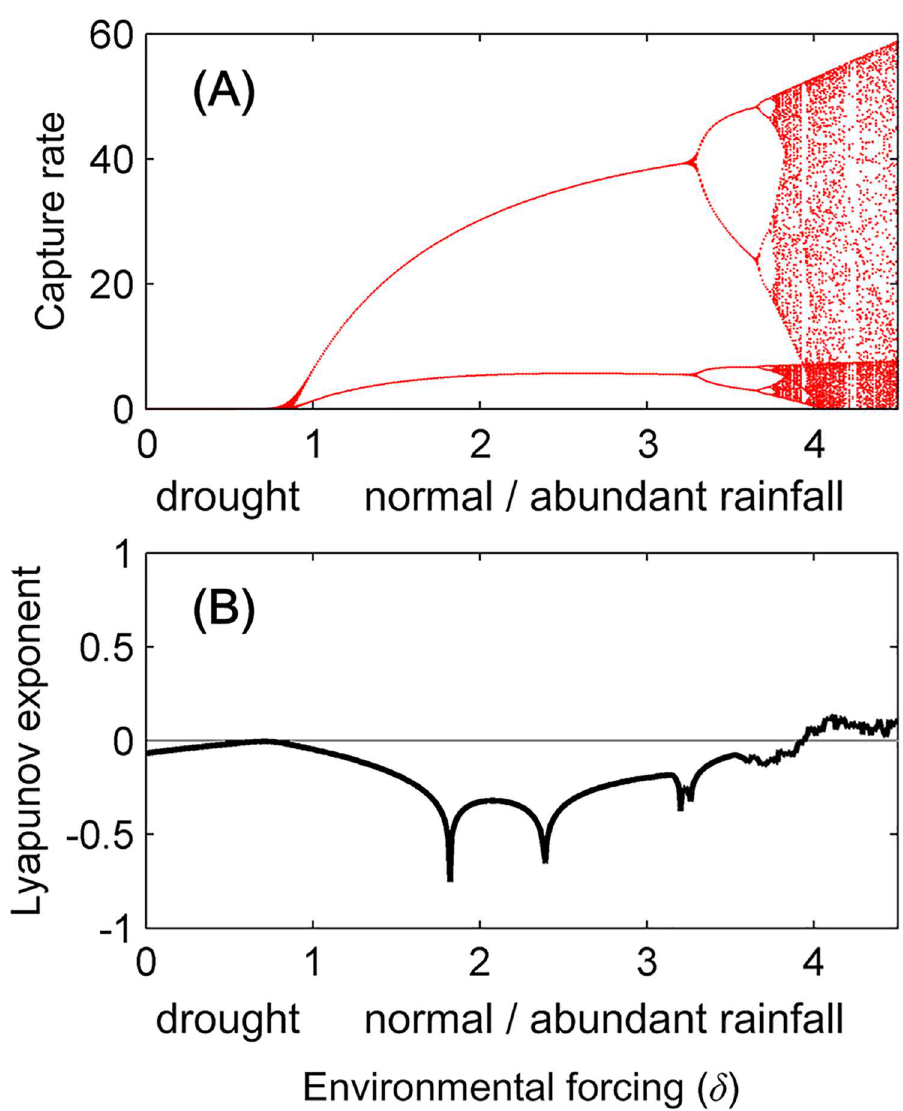
Fig 3. Predicted environmental forcing alters dynamical stability. (A) Bifurcationdiagramshowingthe local minima and maxima of A . agrarius abundance predictedby the environment-basedwildlifedynamic model as a function of the environmental forcing parameter δ (Eqs. 12, 13, see SupportingInformation). The system heads toward extinctionwith drought, followedby stable populationdynamicswith densitiesthat increaseas rainfallincreases,followedby outbreaks with abundantrainfalland amplitudes that increase with rainfall. Precipitation status (drought/normal/abundant rainfall) is quantifiedby the corresponding environmental forcing intensity, δ , which rangedfrom 0 to 4.5. (B) Lyapunov exponent versus environmental forcing, predictedby the environment-basedwildlifedynamic model. The black line shows the Lyapunov exponent calculatedover 100 years with averageenvironmental